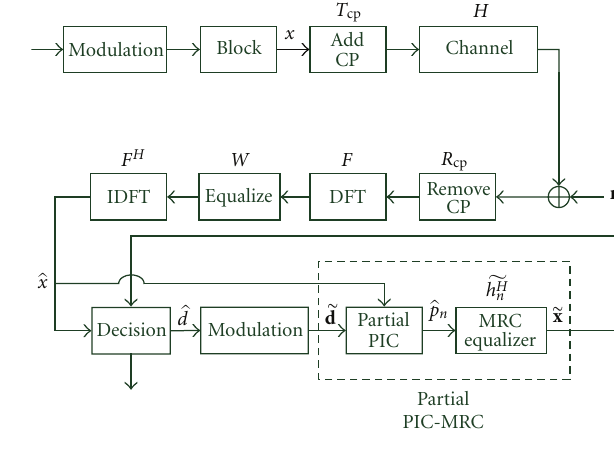
Figure 6: Block diagram of iterative partial PIC-MRC in SCBT system.